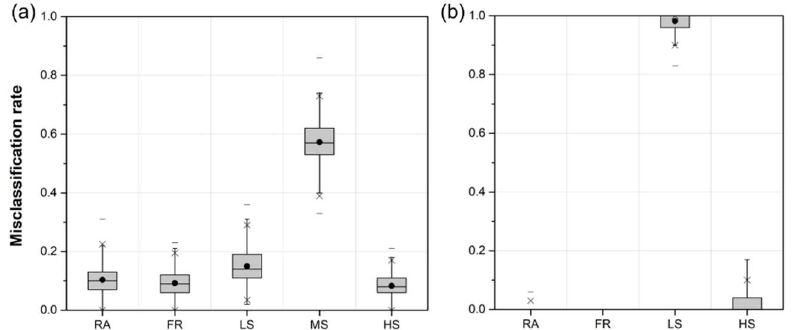
Figure 6. The distribution of ( a ) random forest (RF)’s misclassification rate with respect to each precipitation class. The classes presented in ( b ) indicate RF’s misclassification for MS, which shows the highest misclassification rate in ( a ).